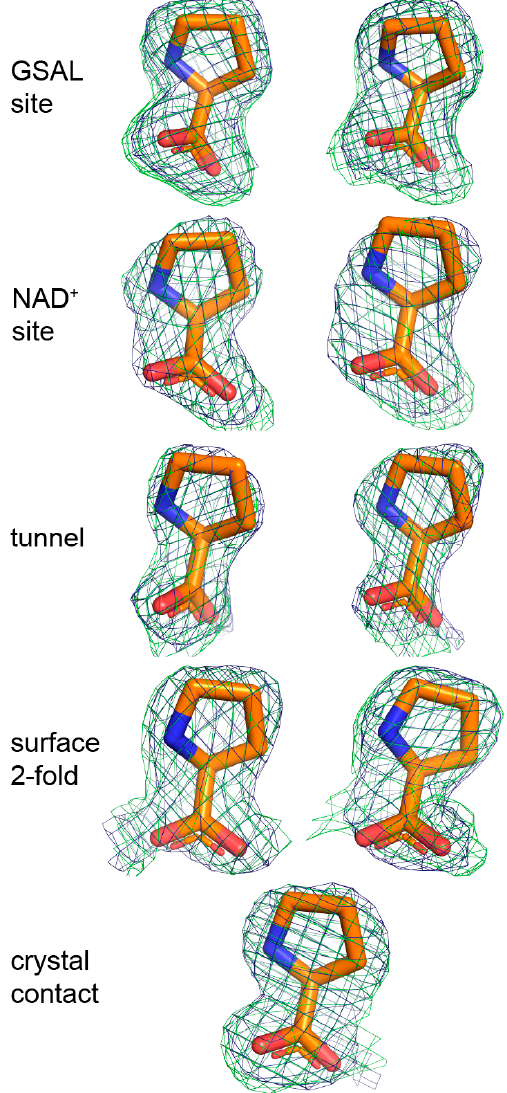
Figure 4. Electron density of the 9 proline molecules bound to C792A. The green mesh represents a simulated annealing F o – F c omit map contoured at 2.5 σ . The blue mesh represents the refined 2 F o – F c map calculated from the final model, including proline ligands (1.0 σ ). The left and right sides of the figure show prolines bound to Chains A and B, respectively. Proline in the crystal contact does not have a non-crystallographic symmetry